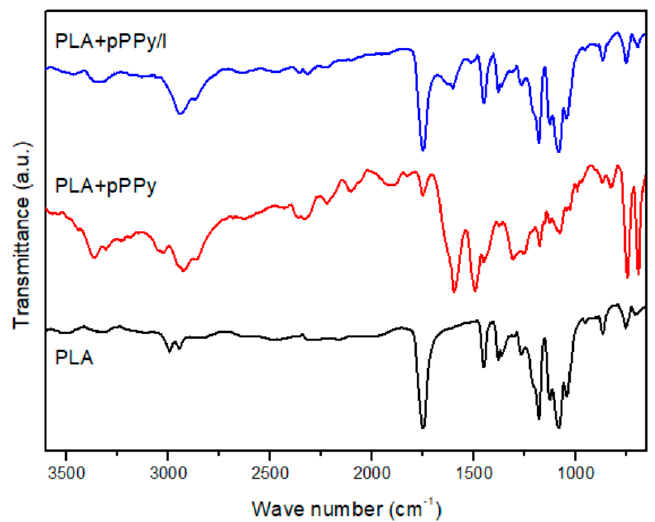
Polymers 2021 , 13 , x FOR PEER REVIEW Figure 3. IR ‐ ATR spectra for PLA, PLA+pPPy, and PLA+pPPy/I. Figure 3. IR-ATR spectra for PLA, PLA+pPPy, and PLA+pPPy/I.